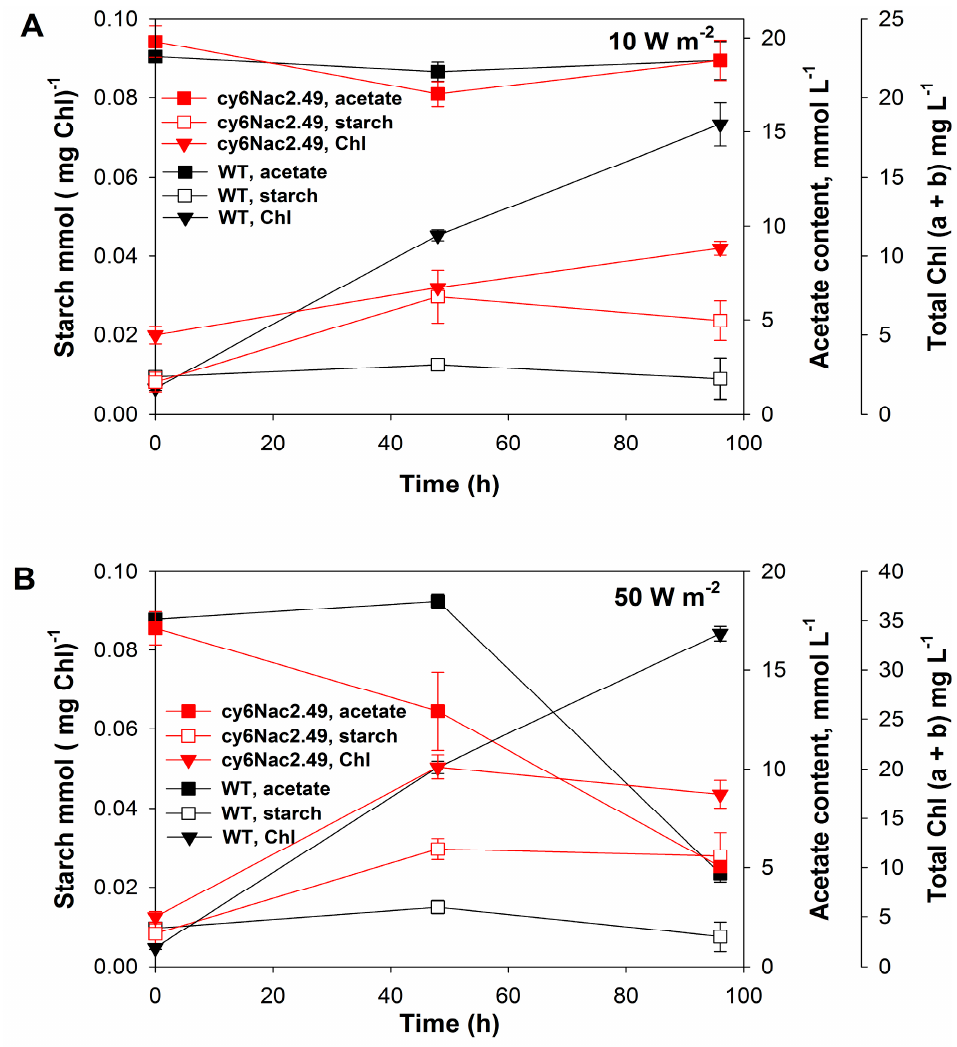
Figure 4. Changes in the total (a + b) chlorophyll (Chl) concentration, the amount of accumulated starch and the acetate content in the medium during the incubation of C. reinhardtii strain cy6Nac2.49 (red) and it is parental wild-type (black) under the light/dark regime at 10 W·m − 2 ( A , B ) 50 W·m − 2 .